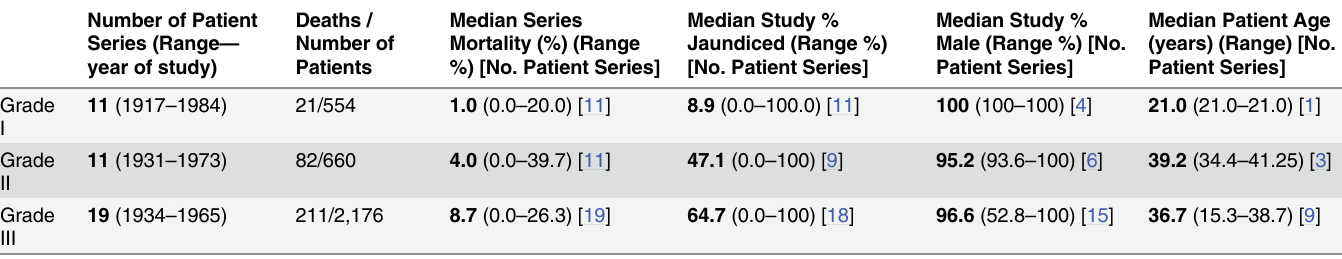
Table 3. Median series mortality stratified according to diagnostic